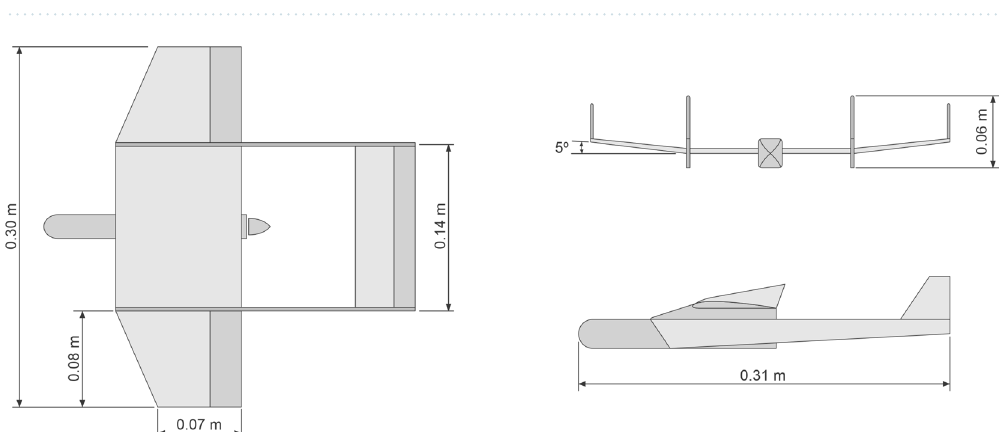
Figure 7. Prototype 6, in a top wing traditional model.